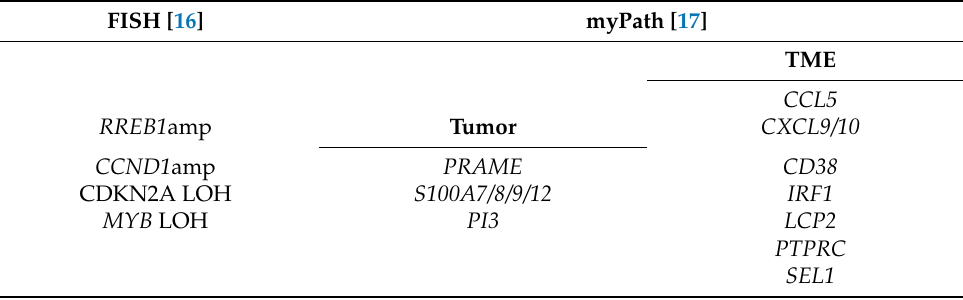
Table 3. Molecular markers of malignancy of melanocytic lesions